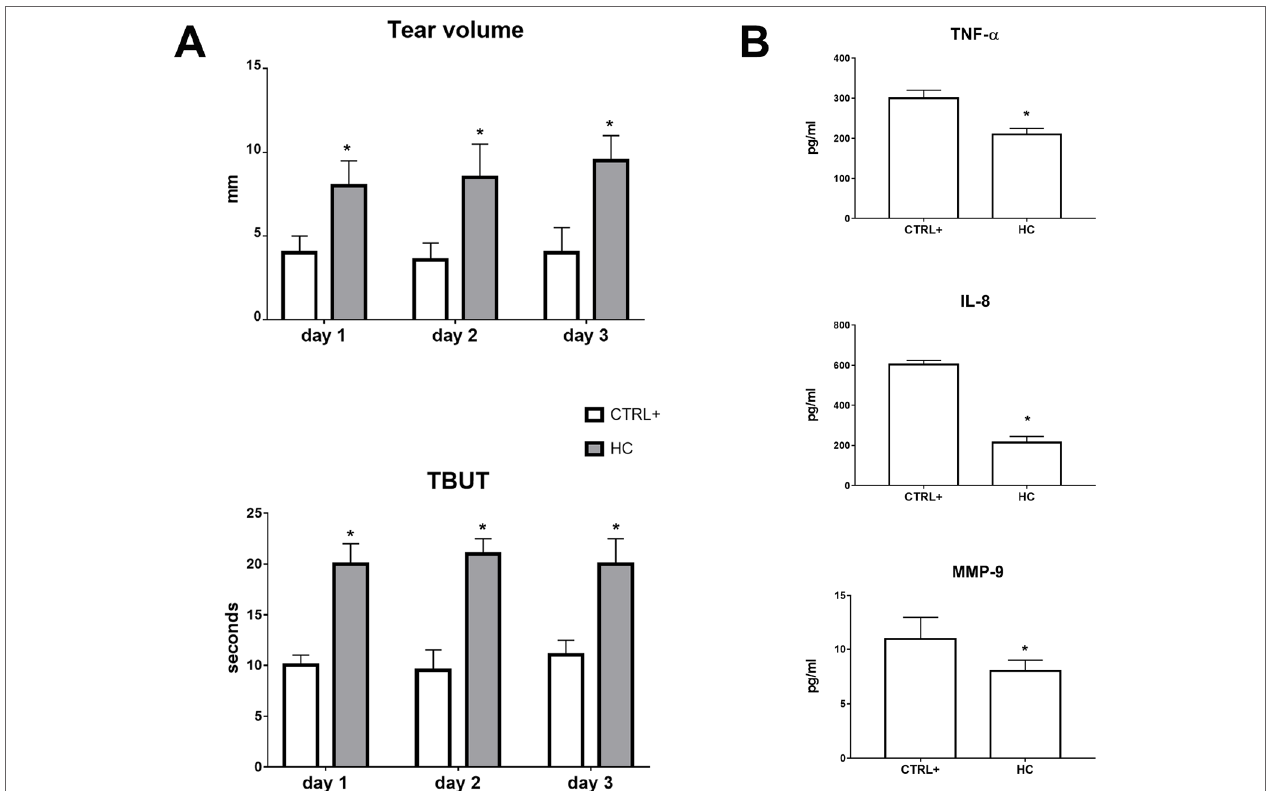
FIGURE 6 | Tear volume, tear film stability (A) , and inflammatory biomarkers (B) in ConA induced dry eye model. TBUT, tear breakup time. *p < 0.05 HC vs. CTRL+ (eye treated with atropine; no treatment with HC); HC, hydrocortisone; ConA, concanavalin A; n =